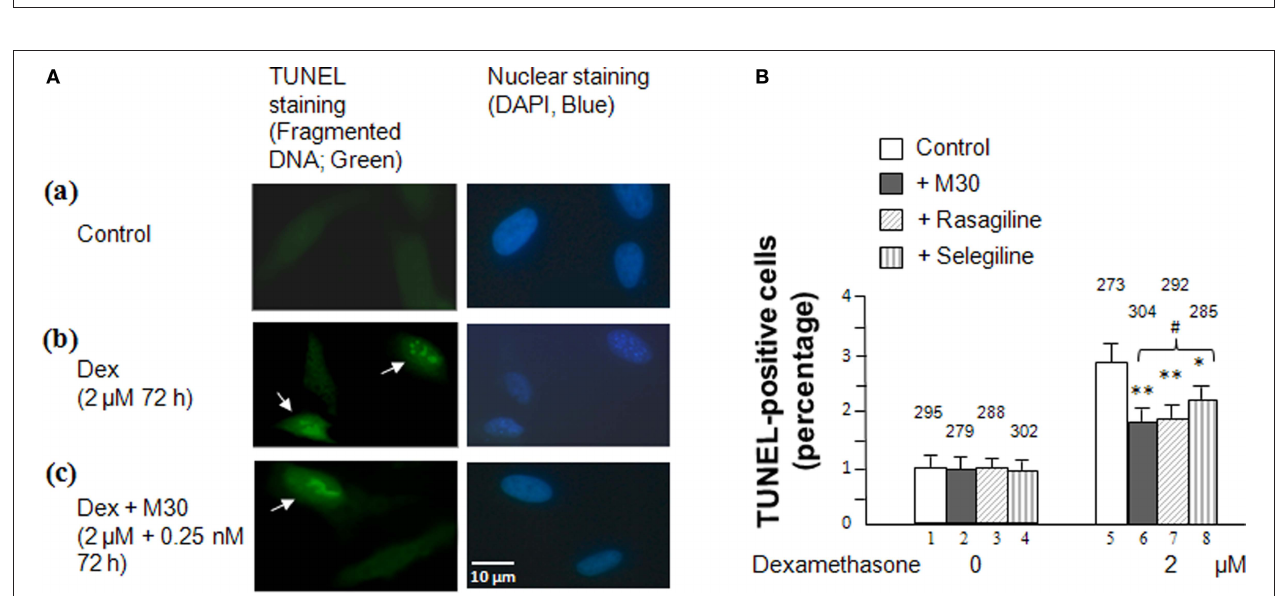
Figure 2 | effects of dexamethasone and MAO inhibitors on cell survival rates (cell proliferation rates) of SH-SY5Y cells. Cells were treated with dexamethasone (2 μM) with and without the MAO inhibitors (0.25 nM) for 72 h. The cell survival rates were determined by MTT assay. * P < 0.05 and ** P < 0.02 compared to cells treated with dexamethasone alone. # P < 0.05 compared lanes 5 vs. 3 and 4.